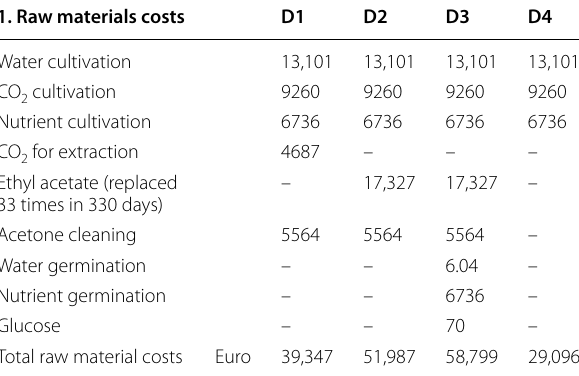
Table 7 Raw material costs of the biotechnological production of H. pluvialis, comparing four different downstream scenarios D1, D2, D3, and